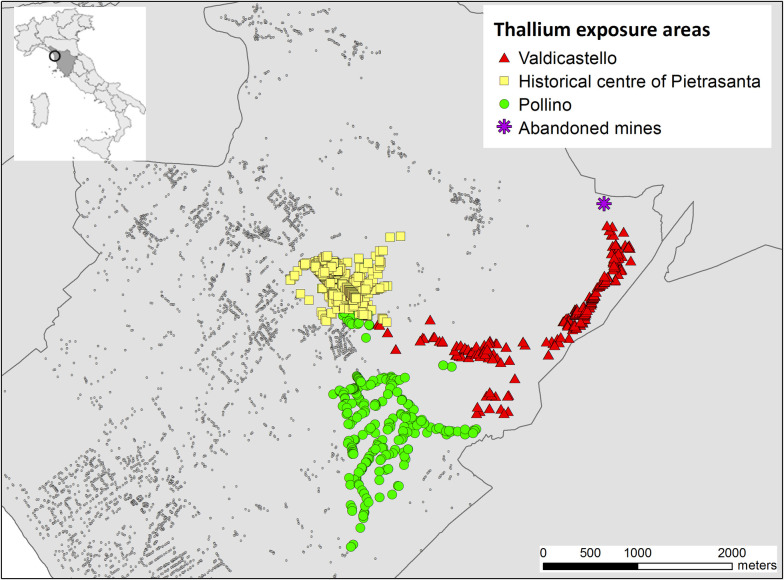
Map of the thallium contaminated areas.In red the Valdicastello area (concentration of TI in water up to 79.5 μg/L), in yellow the centre of Pietrasanta (concentration of TI in the water up to 6.80 μg/L), in green the Pollino area (concentration of TI in the water up to 8.40 μg/L), in grey the area not affected by the pollution (concentration of TI in the water up to 2.0 μg/L). Data source: Tuscany Region—datasets “ambiti_amministrativi.zip and iternet.zip” released under the Creative Commons Attribution 4.0 license.